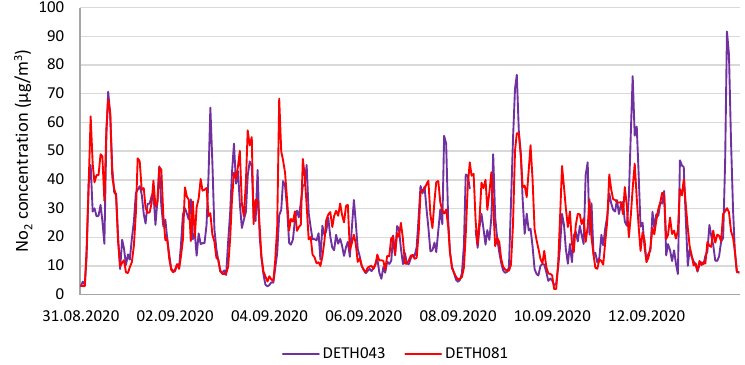
Figure 6. NO 2 concentration for urban sensors, September 2020, first two weeks sensors.